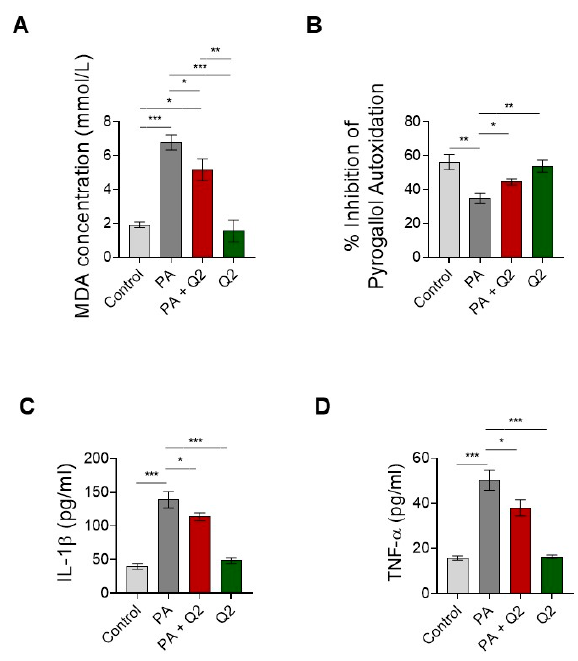
Figure 7. Effects of Q2 on the levels of malondialdehyde (MDA) and superoxide dismutase (SOD) activity and the levels of IL-1 β and TNF- α in PA-treated cells. ( A ) MDA concentration, ( B ) SOD activity in lysates of H9c2 cardiomyocytes treated with vehicle (control), PA (200 µM), Q2 (250 nM) for 2 h and then PA for 24 h, and Q2 alone (250 nM) for 24 h. ( C ) IL-1 β and ( D ) TNF- α levels in culture supernatant of H9c2 cardiomyocytes treated with vehicle (control), PA (200 µM), Q2 (250 nM) for 2 h and then PA for 24 h, and Q2 alone (250 nM) for 24 h. MDA concentration and SOD activity, as oxidative stress-related markers, were expressed as mmol/L and as percentage of inhibition of the pyrogallol autoxidation rate, respectively. The levels of IL-1 β and TNF- α , as specific pro-inflammatory markers, were expressed as pg/mL. Data are expressed as the mean ± SEM of six separate experiments. Significant differences were detected by one-way ANOVA and Newman–Keuls multiple comparison test, p < 0.05 (*); p < 0.01 (**); and p < 0.001 (***).